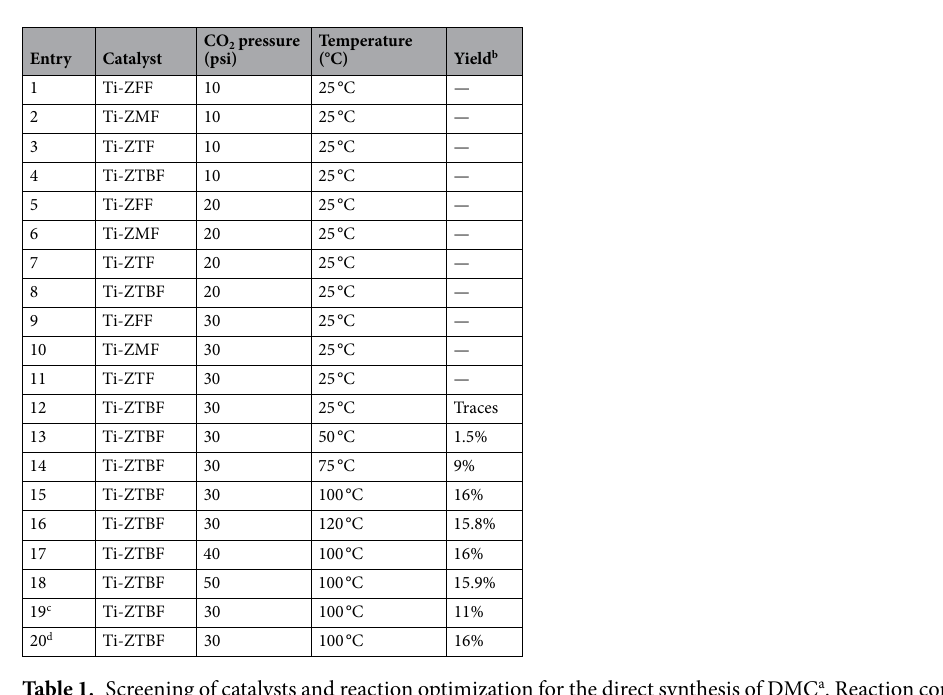
Table 1. Screening of catalysts and reaction optimization for the direct synthesis of DMC a . Reaction condition: a Methanol (5.0 ml), catalyst (100 mg); b Isolated yield. c 50 mg of Ti-ZTBF; d 150 mg of